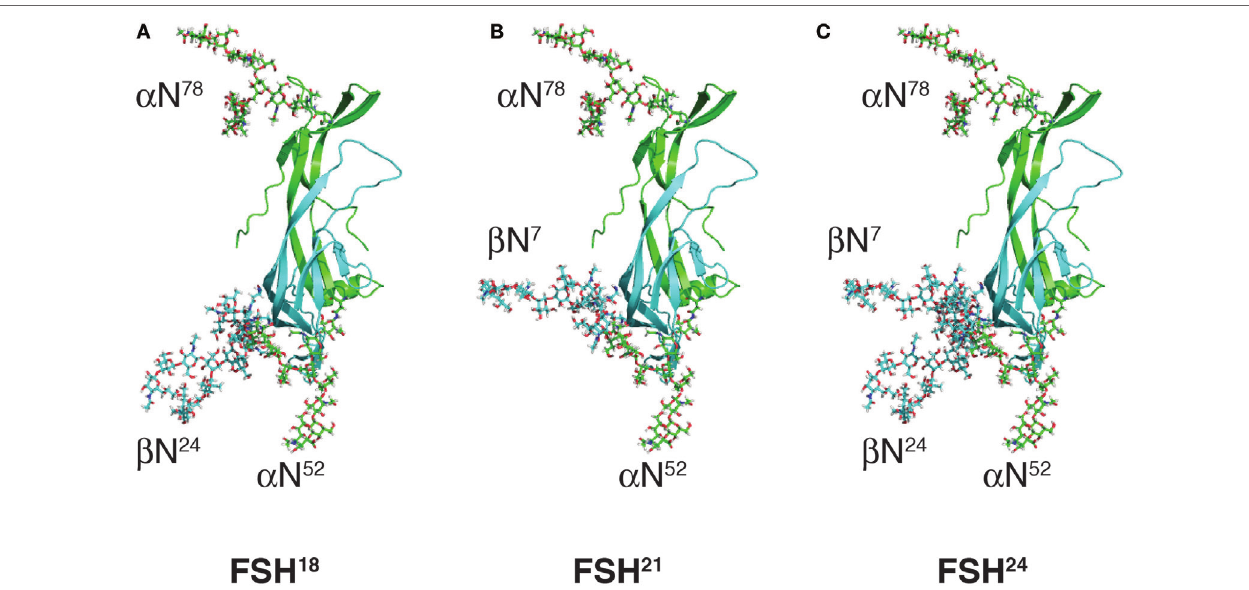
FiGURe 2 | Follicle-stimulating hormone (FSH) glycoform models. Models of FSH heterodimers extracted from pdb 4AY9 decorated with the most abundant glycan observed at each N-glycosylation site by nano-ESI-ion mobility-MS (Bousfield, G. R. and Harvey, D. J., unpublished). Subunits are shown as cartoons rendered by MacPyMOL with subunits and their oligosaccharides colored as in Figure 1 ; FSH α green and FSH β cyan. Oligosaccharides shown as sticks were created and attached to the FSH model using GLYCAM [Woods Group. (2005–2017) GLYCAM Web. Complex Carbohydrate Research Center, University of Georgia, Athens, GA, USA. (http://glycam.org)]. (A) FSH 18 , which lacks Asn 24 glycan. (B) FSH 21 , which lacks Asn 7 glycan. (C) FSH 24 , which possesses all four